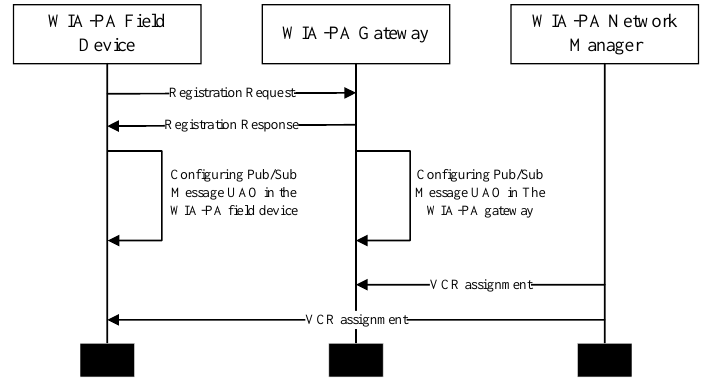
Figure 10. Time sequence flowchart.